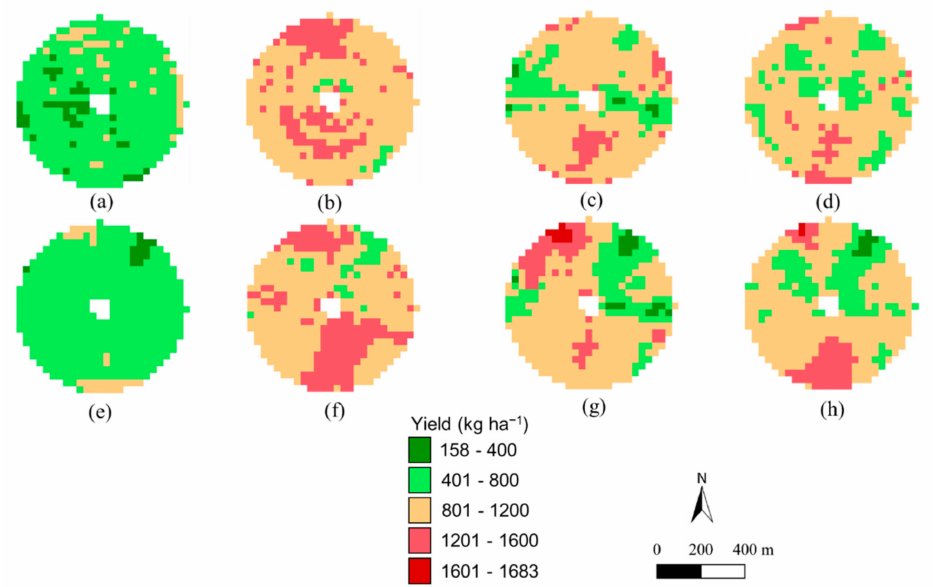
Figure 8. Geospatial variations in ( a – d ) observed and ( e – h ) simulated cotton lint yield at field #30, Halfway, Texas, USA, in ( a , e ) 2000, ( b , f ) 2001, ( c , g ) 2002, and ( d , h ) 2003.